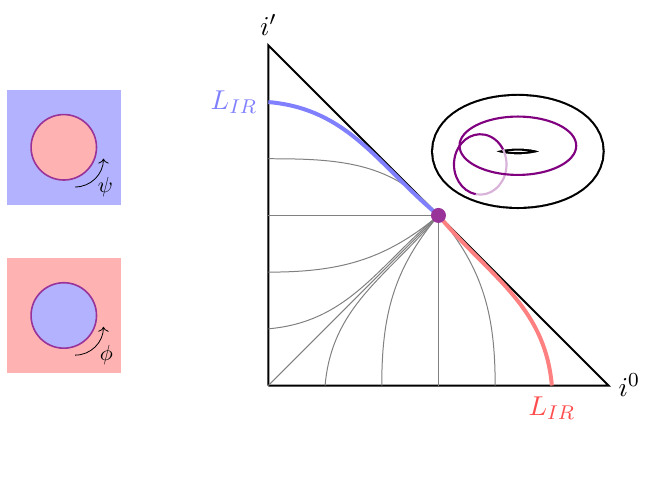
Figure 4 . Penrose diagram for R 2 , 2 . Null infinity is resolved by two AdS 3 / Z hyperboloids at fixed X 2 = ± L 2 glued together along a celestial torus. These hyperboloids cap off different cycles of the IR celestial